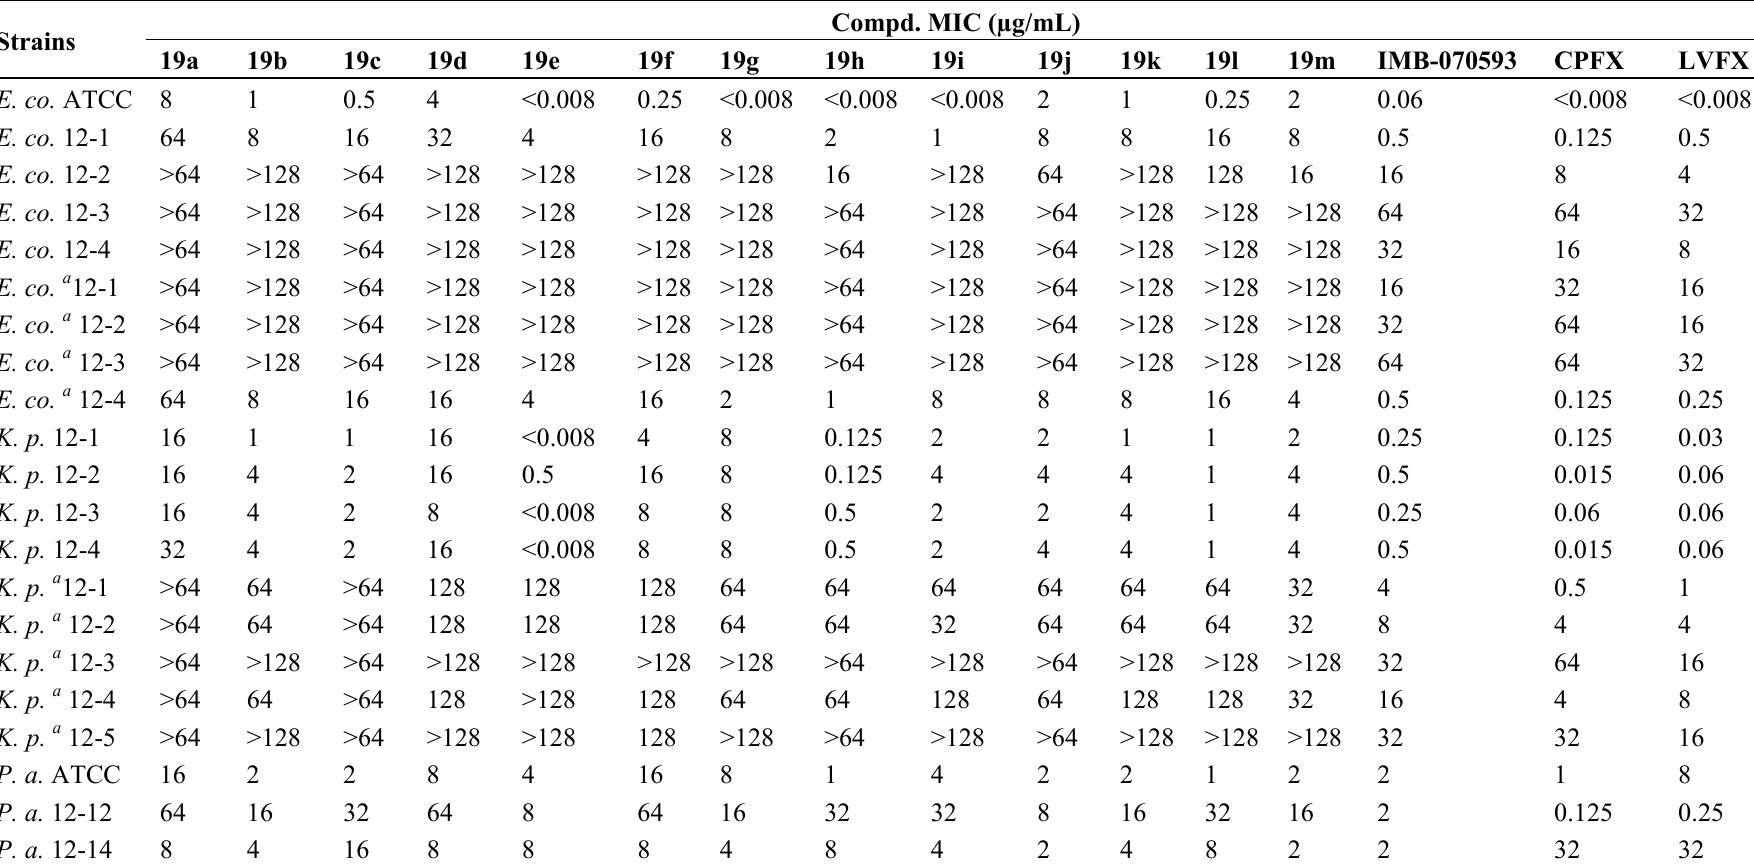
Table 3. In vitro antibacterial activity of compounds 19a – m against Gram-negative